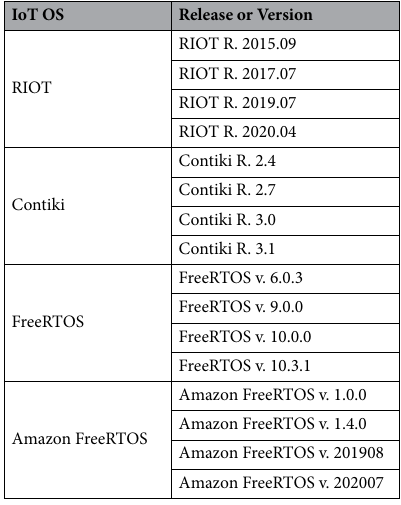
Table 1. The IoT OSs releases used for dataset